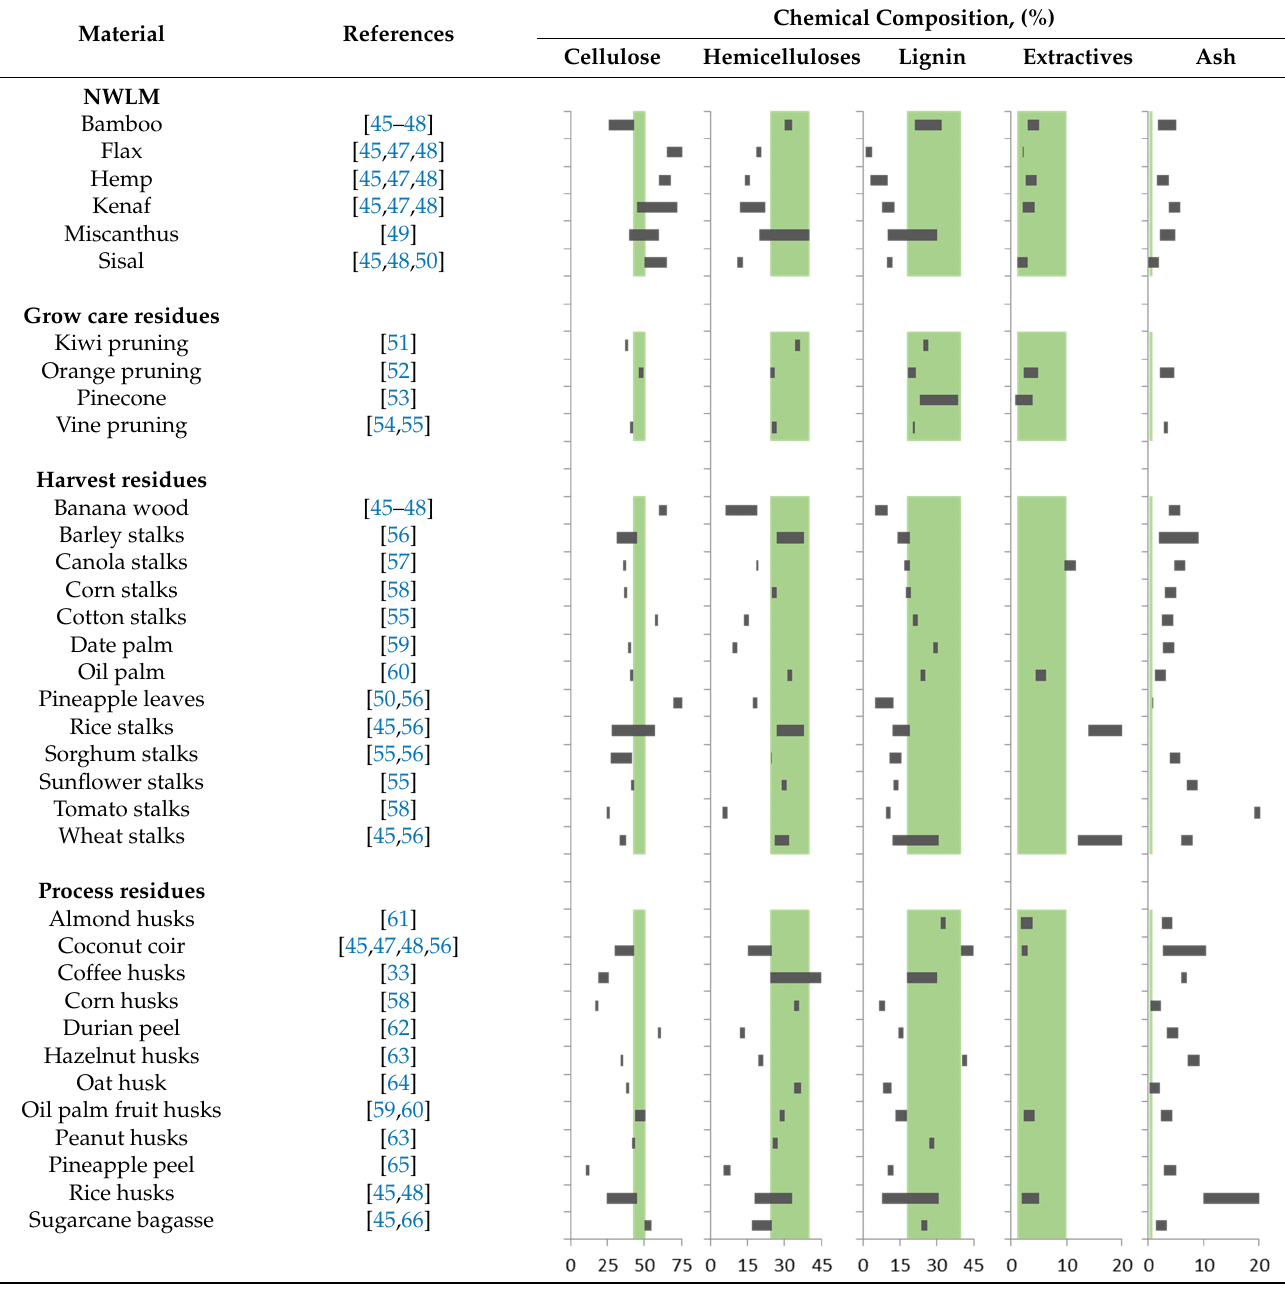
Table 3. Chemical composition (%) of alternative NWLMs and agricultural residues (black bars) as compared with wood (softwoods and hardwoods combined, and green background bars), adopted from references.